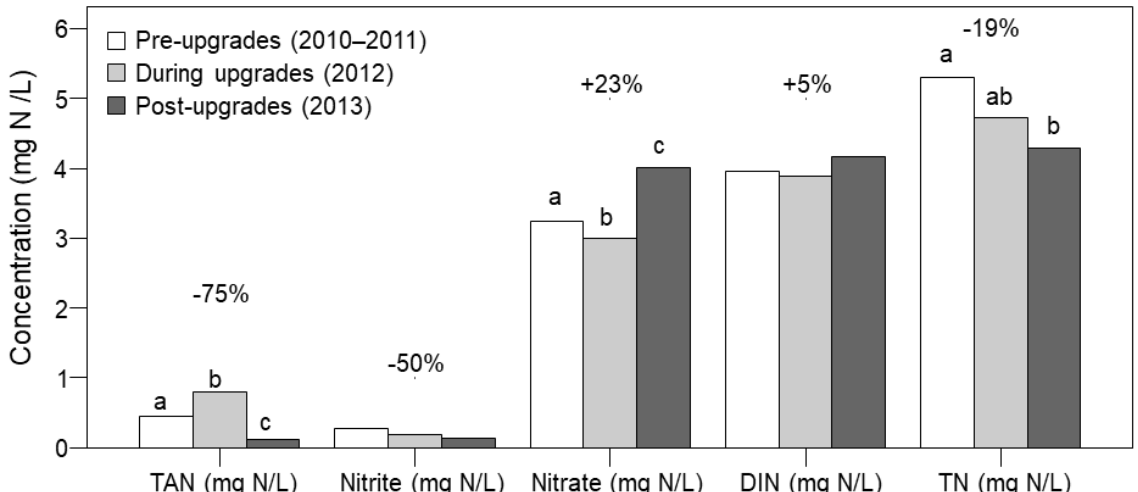
Figure 4. Changes in annual average concentration of water quality parameters at the location Blair, 5.7 km downstream of Kitchener wastewater treatment plant. Values with different letters (a, b, c) are statistically different: post hoc test LSD (a = 0.05). Pre-upgrades (2010–2012, n = 66) and post-upgrades (2013, n = 17). Samples represent daytime concentrations. River discharge obtained from the Grand River Information Network (GRIN Open Data License v1.0).